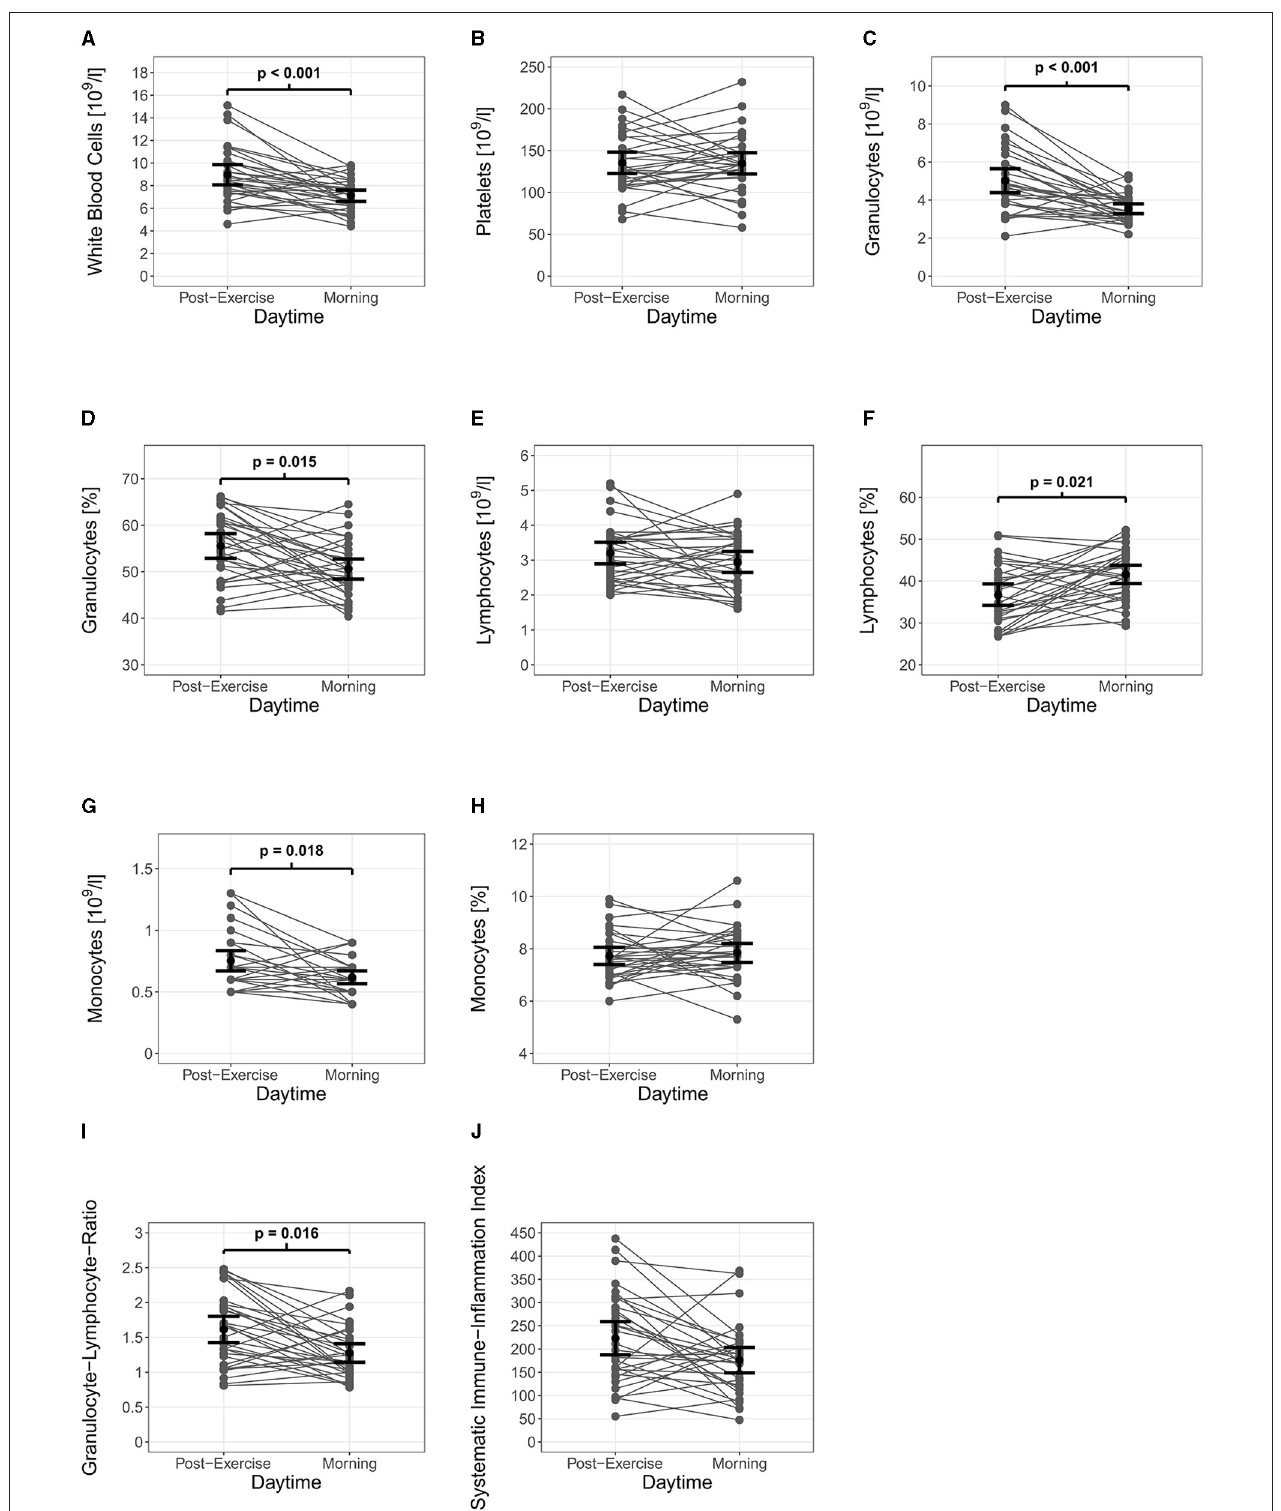
FIGURE 2 | Immune regulation of capillary immunological blood markers and inflammatory indexes with 95% CI. White blood cells (A) , granulocytes (C) , granulocytes % (D) , monocytes (G) and granulocyte-lymphocyte-ratio (I) decreased significantly from post-training to the next morning. Lymphocytes % (F) showed significant decreases, while platelets (B) , lymphocytes (E) , monocytes % (H) , and systemic inflammation index (J) showed no significant changes.